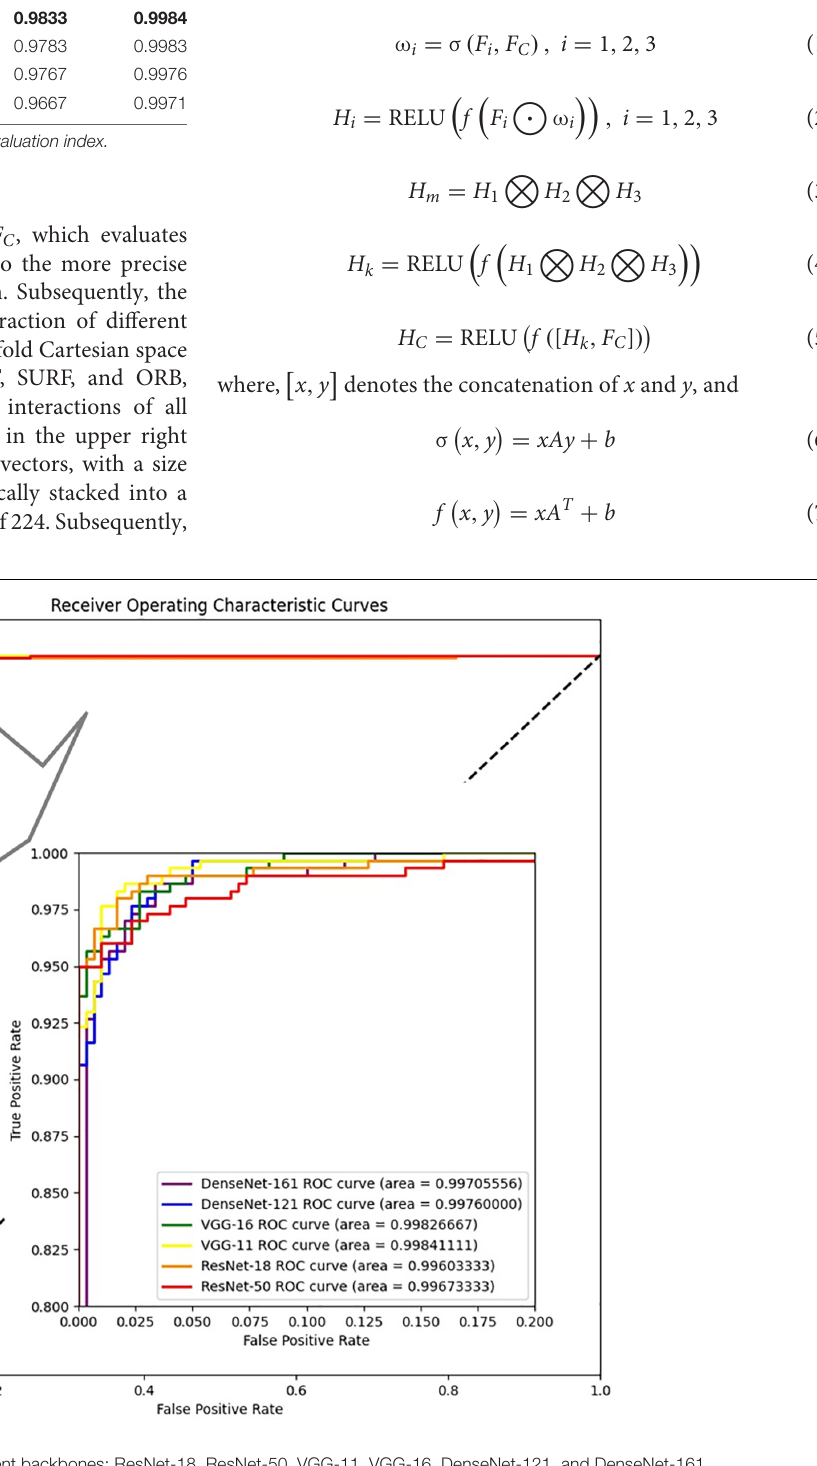
Frontiers in Microbiology |